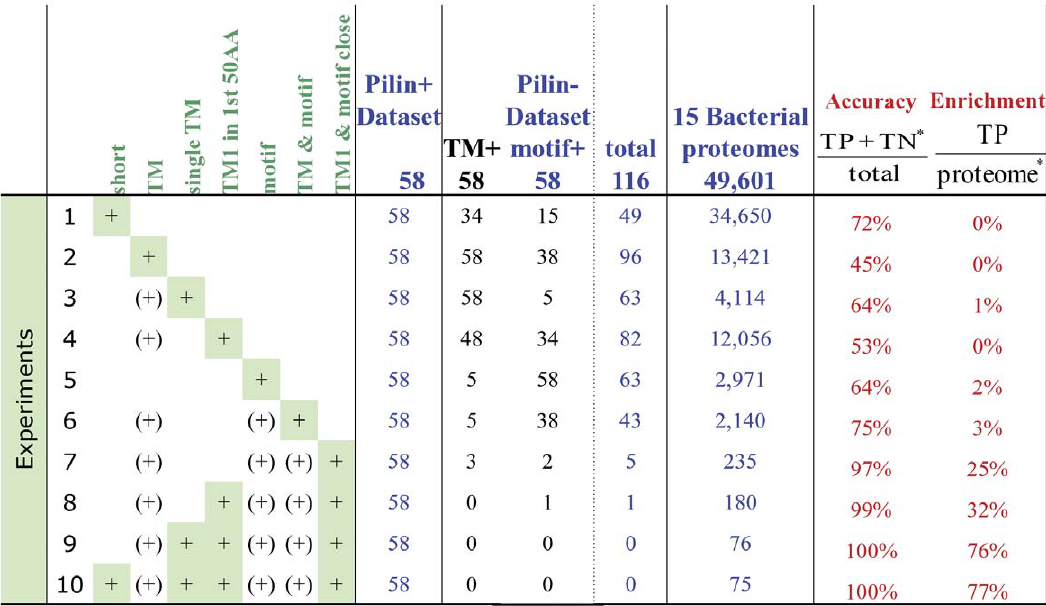
Figure 5. Combining features for better identification of type IV pilins. Criteria applied to the 58 protein positive training dataset, the 116 protein negative training dataset, and 15 Gram-positive bacterial genomes from which the positive training set was assembled; ‘‘Short’’, protein sequence length # 350 amino acids; ‘‘TM’’, presence of a transmembrane domain, a single TM, or the first TM within the N-terminal 50 amino acids; ‘‘Motif’’, presence of the characteristic prepilin peptidase cleavage recognition site followed by 14 non-charged amino acids, or in close proximity ( # 13 amino acids) to the first TM. Green shading indicates criteria applied in these computational experiments. ‘‘TP’’, true positive; ‘‘TN’’, true negative; ‘‘proteome’’, the proteins satisfying the criteria applied.